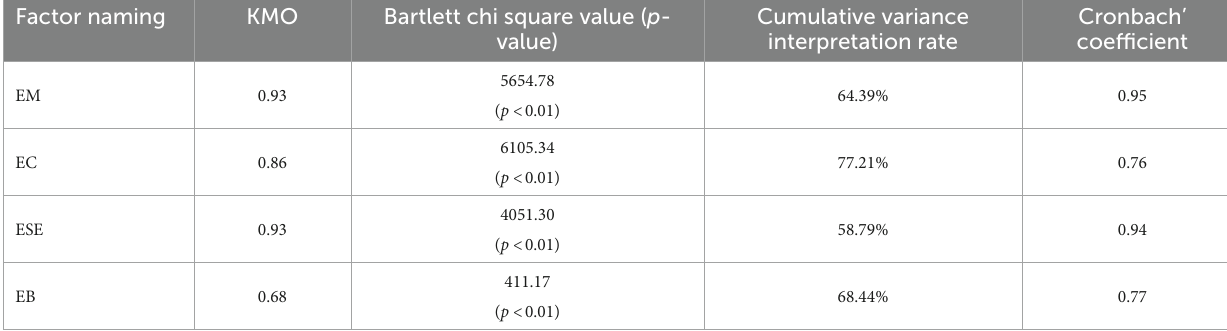
TABLE 1 Exploratory factor analysis and internal consistency test results.